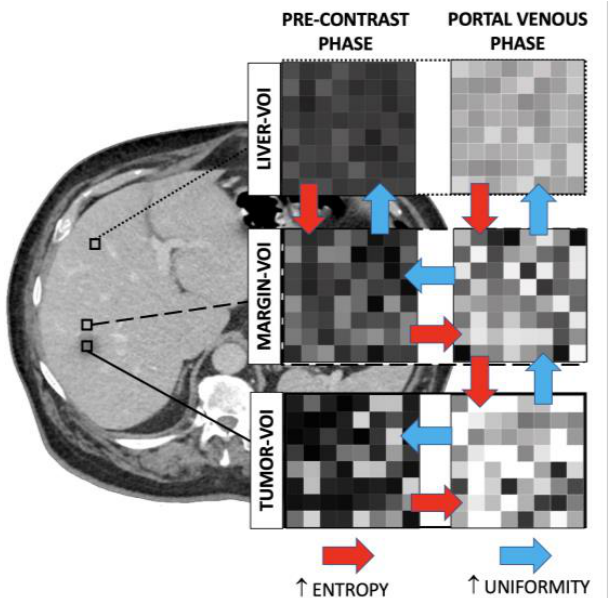
Figure 5. Entropy and uniformity across volumes of interests (VOIs) in the two phases. Red arrow: Significant increase in entropy; Blue arrow: Significant increase in uniformity.